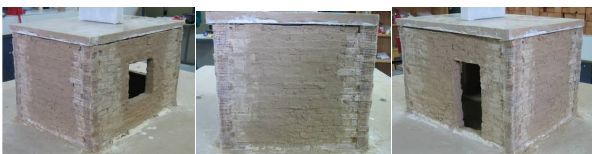
Fig. 13 Preperation of specimen CF3 Fig. 13. Preperation of specimen